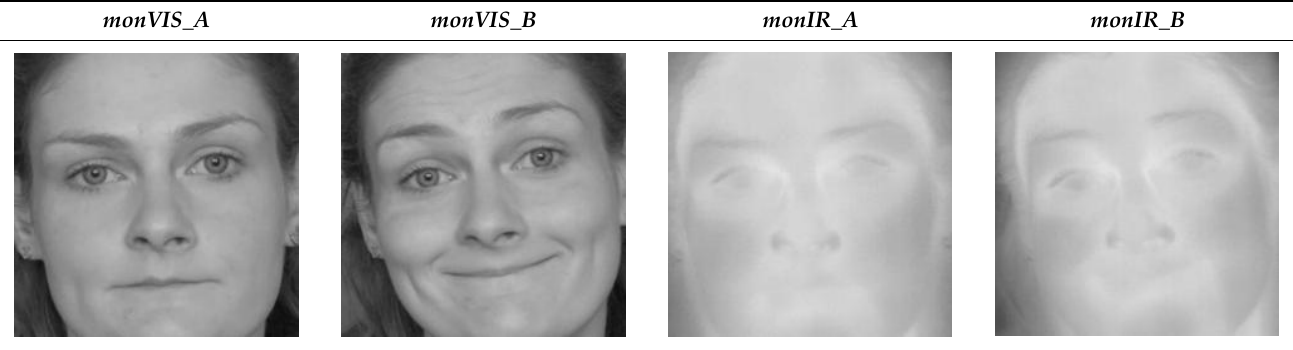
Table 2. Table 2. Table 2. Table 2. Table 2. Proposed components for filling RGB channels on the example of a selected person. Table 2. Proposed components for filling RGB channels on the example of a selected person. Table 2. Proposed components for filling RGB channels on the example of a selected person. Table 2. Proposed components for filling RGB channels on the example of a selected person. Table 2. Table 2. Table 2. Proposed components for filling RGB channels on the example of a selected person. Table 2. Proposed components for filling RGB channels on the example of a selected person. Table 2. Proposed components for filling RGB channels on the example of a selected person. Table 2. Proposed components for filling RGB channels on the example of a selected person. Table 2. Proposed components for filling RGB channels on the example of a selected person.